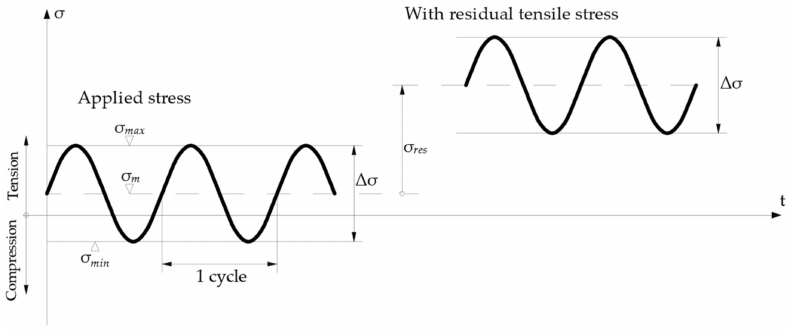
Figure 2. Parameters of cyclic action and influence of residual stresses.